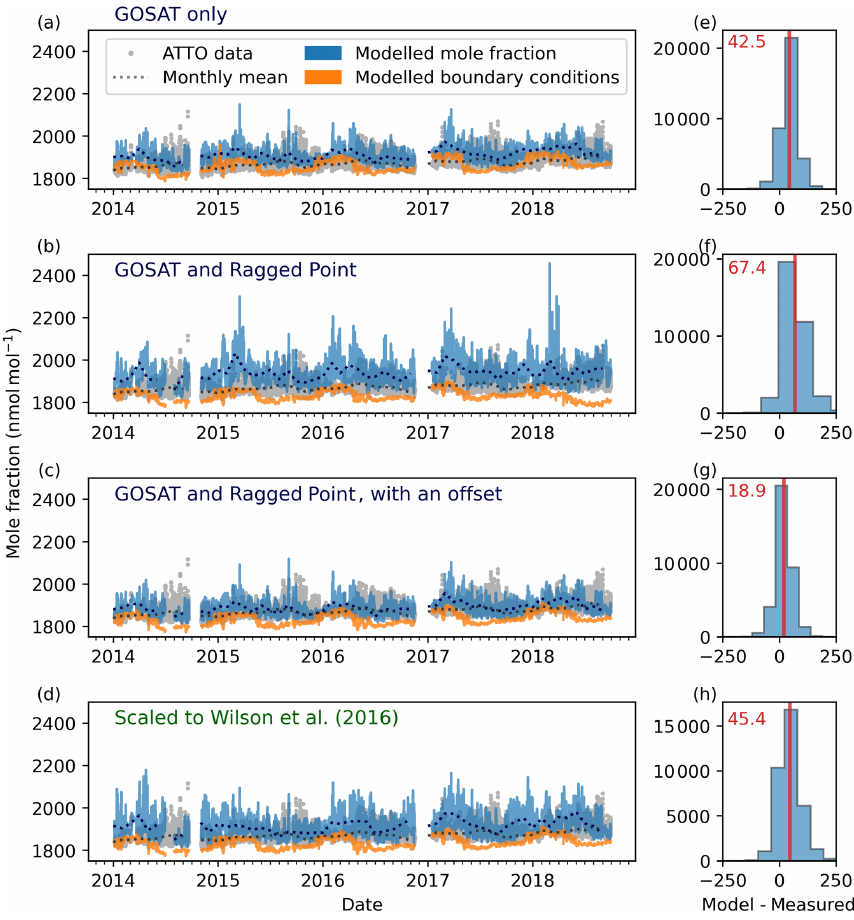
Figure 8. (a–d) Comparison of modelled and measured mole fractions at ATTO for different posterior emissions with (e–h) histograms of the differences. Posterior emissions derived in inversions using (a, e) GOSAT measurements only, (b, f) both GOSAT and RPB data but no offset parameter in the inversion, and (c, g) both GOSAT and RPB data with an offset parameter between the two datasets in the inversion. (d, h) Posterior emission distribution of our main results but scaled so that total CH 4 emissions in the Brazilian Amazon were equivalent to those derived in Wilson et al.